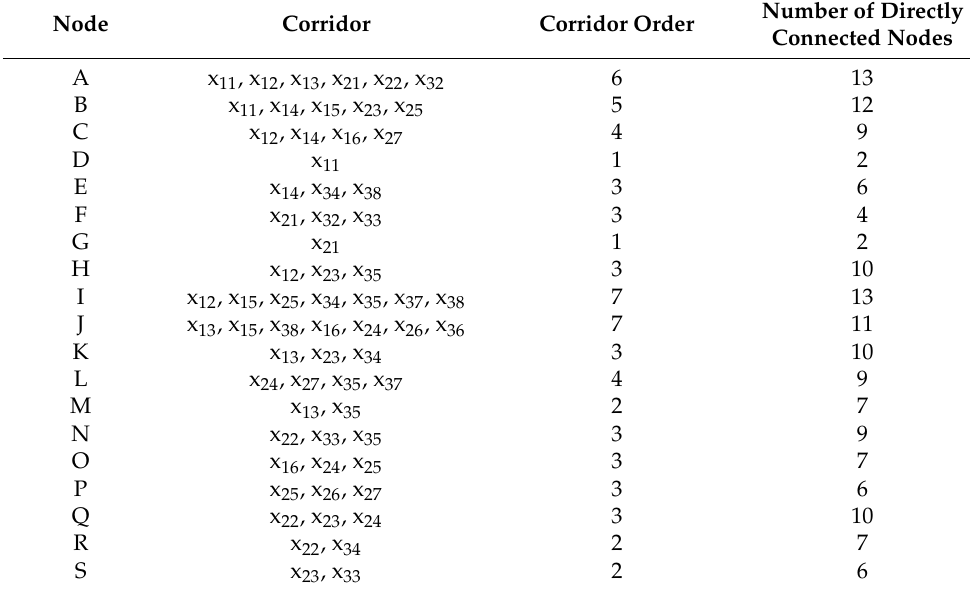
Table 2. Attributes of inter-group corridors connection.